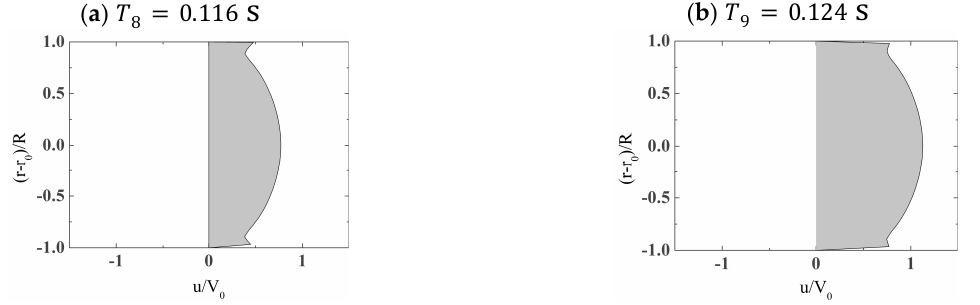
Figure 19. Axial velocity distribution at different time ( 𝑇 8 = 0.116 s and 𝑇 9 = 0.124 s ) of S1 monitoring point.